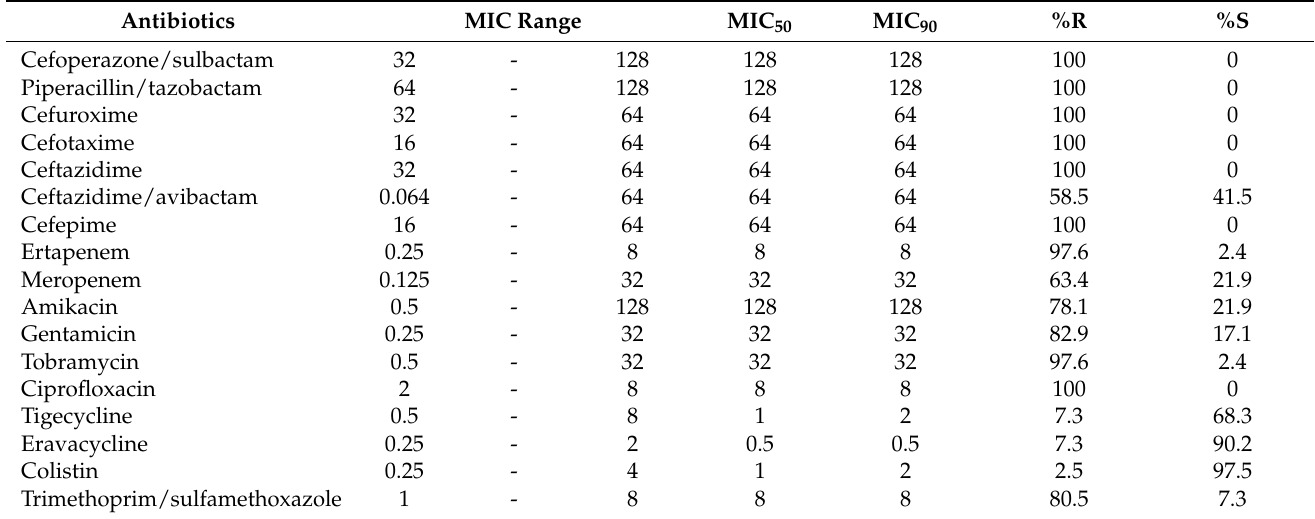
Table 4. Antimicrobial resistance of 41 carbapenem-resistant Klebsiella pneumoniae strains ( µ